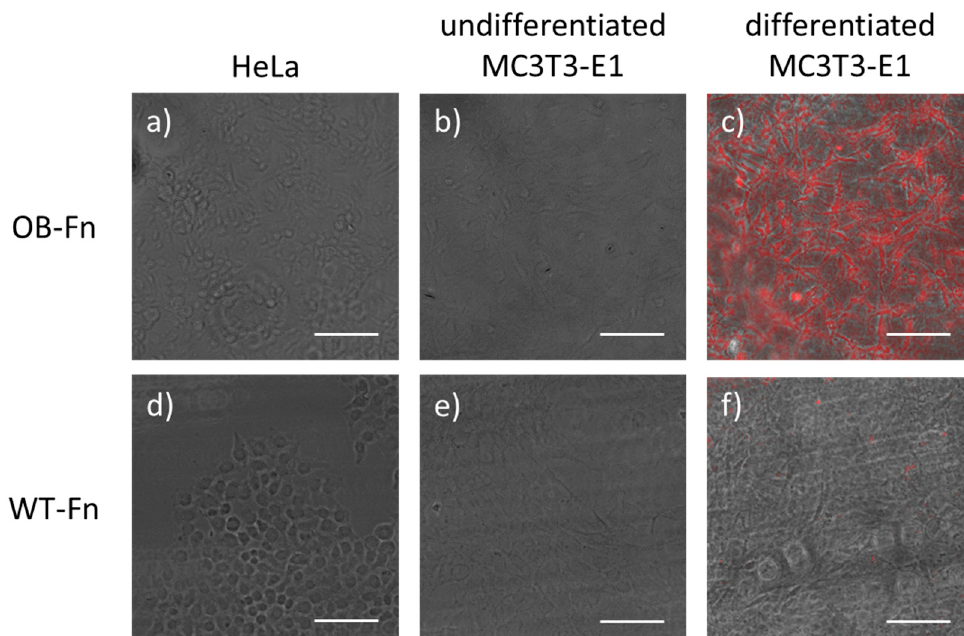
Figure 2. Fluorescent cell imaging for analyzing the binding specificity of OB-Fn. HeLa, undifferen- tiated MC3T3-E1, and MC3T3-E1 cells differentiated for 21 days were incubated with Cy5-labeled (red) ( a – c ) OB-Fn and ( d – f ) WT-Fn. Images of HeLa ( a , d ) and undifferentiated MC3T3-E1 ( b , e ) cells, are presented as merged bright field and Cy5-stained images. Images of differentiated MC3T3-E1 cells ( c , f ) are presented by merging only the bright field and Cy5-stained images. Scale bar 100 nm.